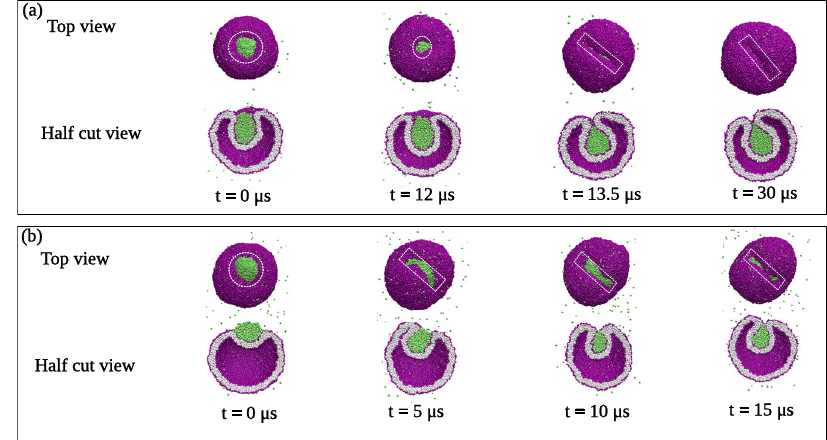
linesat t =13.5 μ sand t =30 μ s.Moredetailsontheshapeevolutionareprovidedby the Movies S5 and S6; and b Nanovesicle formed by N ol =5963 lipids in the outer and N membrane with an axisymmetric contact line, see white dashed circle. The axial symmetry is broken at t =5 μ s, as follows from the strongly noncircular and highly